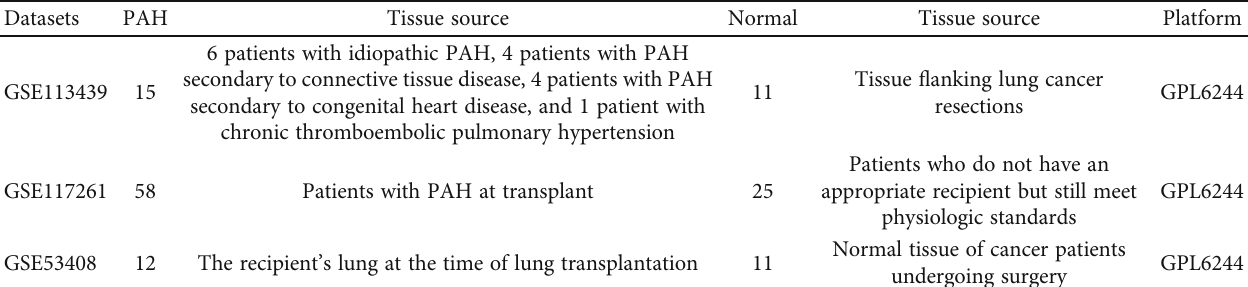
Table 1: Characteristics of three datasets.